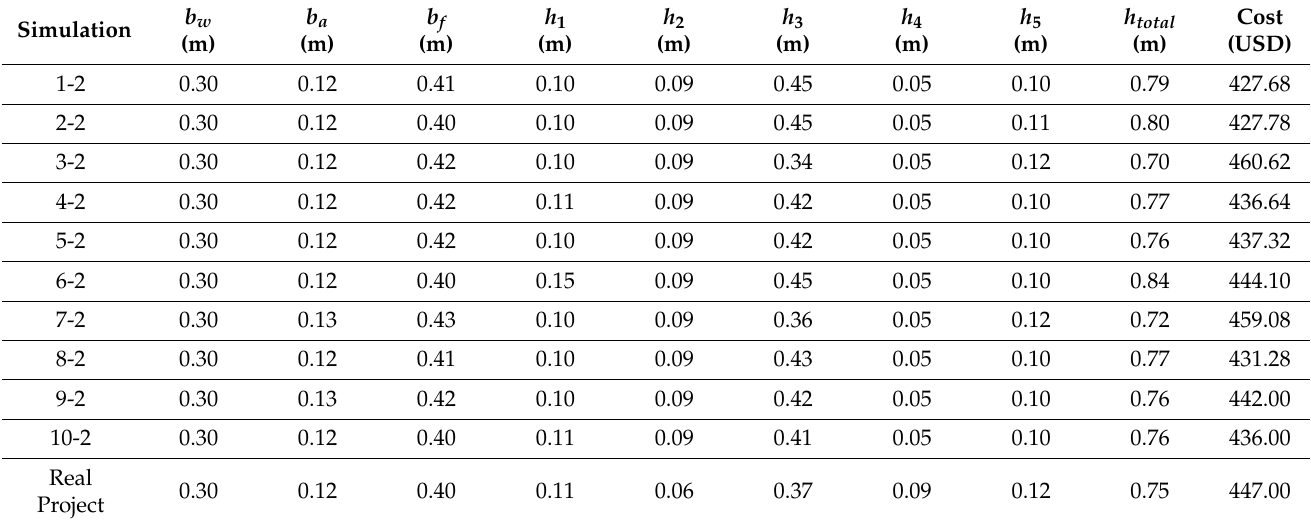
Table 2. Summary of solutions (150 individuals, 500 iterations, 5% mutation rate, and η = 3).